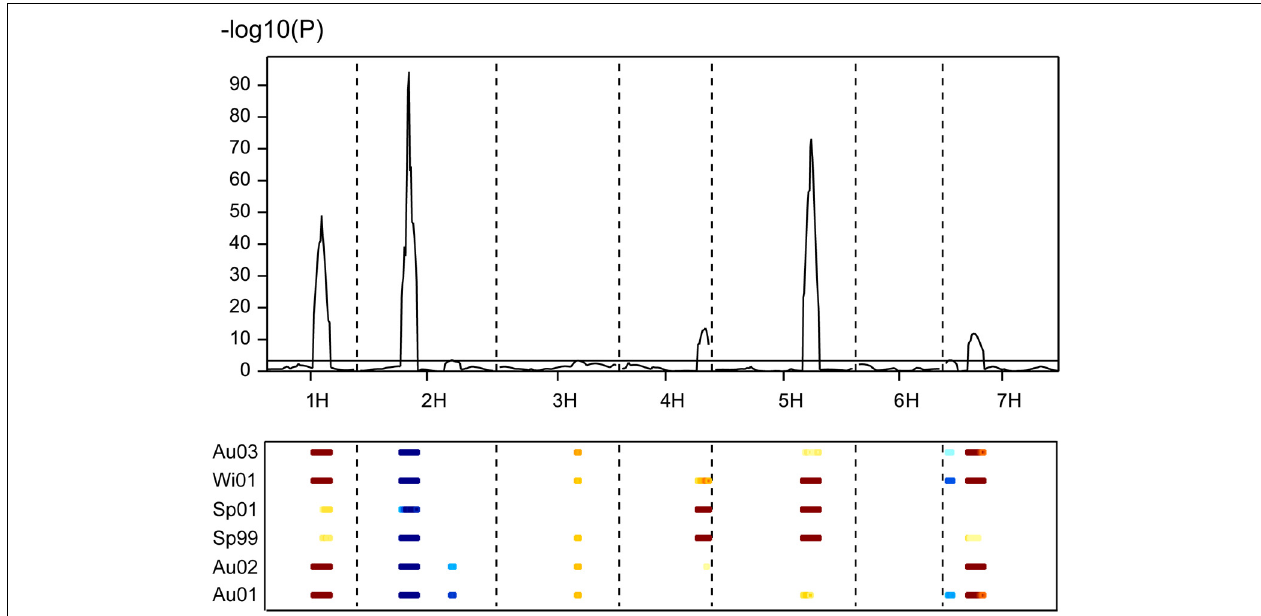
FIGURE 3 | Multi-environment QTL analysis for days to flowering from January1stforsixfieldexperimentscarriedoutwith120doubledhaploid lines and the parents of the population Beka x Mogador. The peaks above the threshold (dashed line) indicate presence of QTL significantly affecting the trait. Data taken from Cuesta-Marcos et al. (2008), enriched with new markers